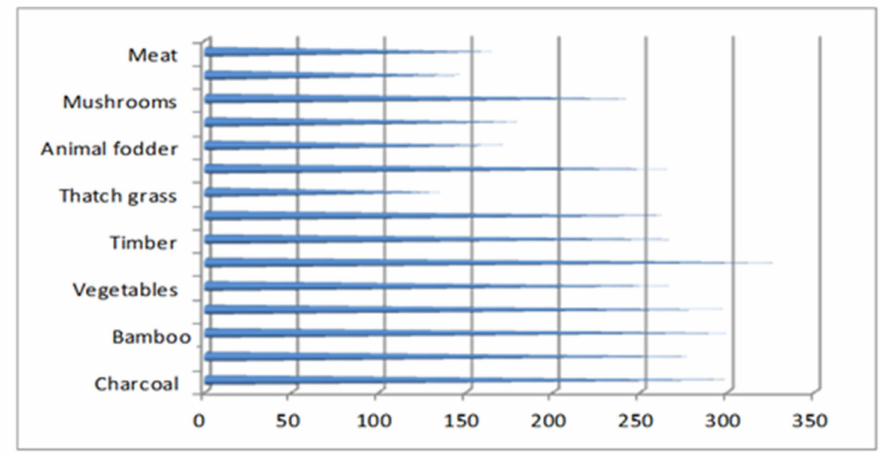
Figure 4. Pattern of forest resource consumption in the area (2019). Source: author’s field survey, 2019.